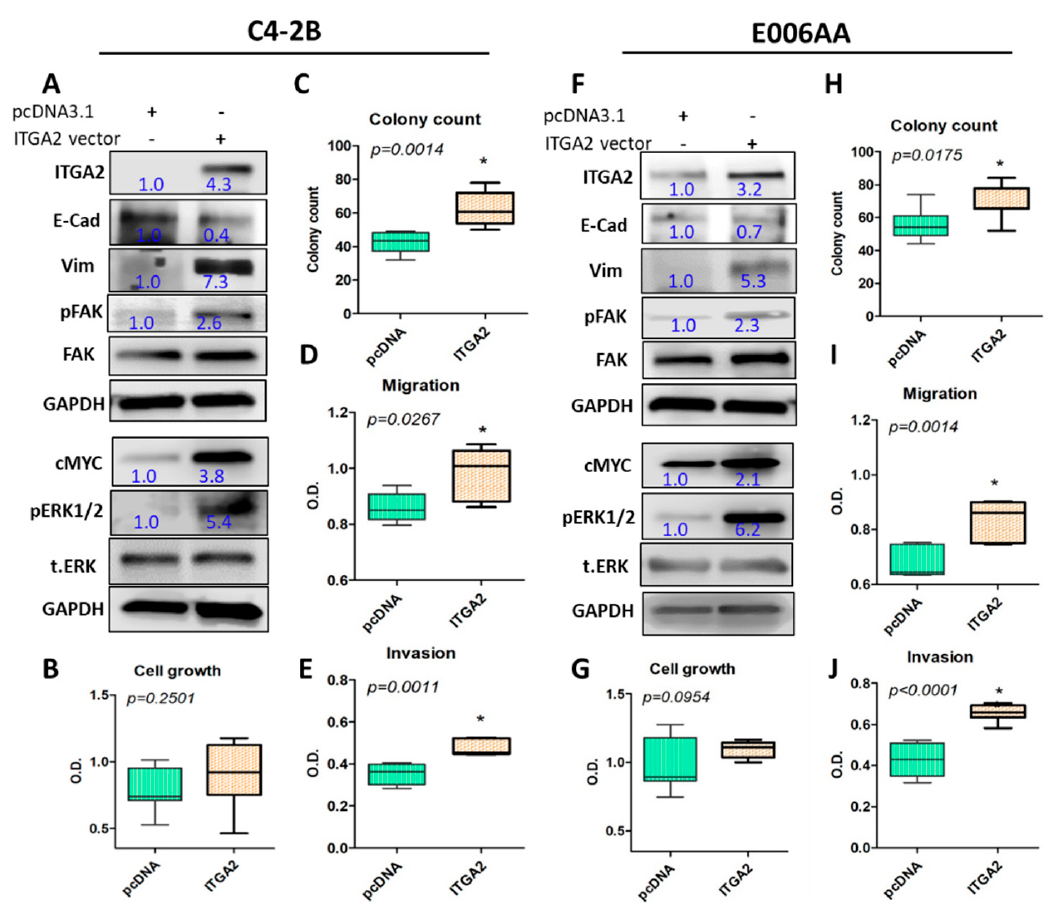
Figure 5. Ectopic expression of ITGA2 promotes aggressive phenotypes in PCa cells. C4-2B and E006AA cells were transfected with 2.5 µ g plasmid carrying ITGA2 or pcDNA3.1 as a control plasmid for 96 h.